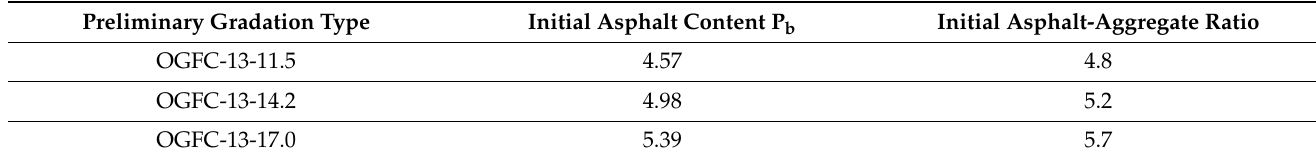
Table 8. Gradation test parameters.